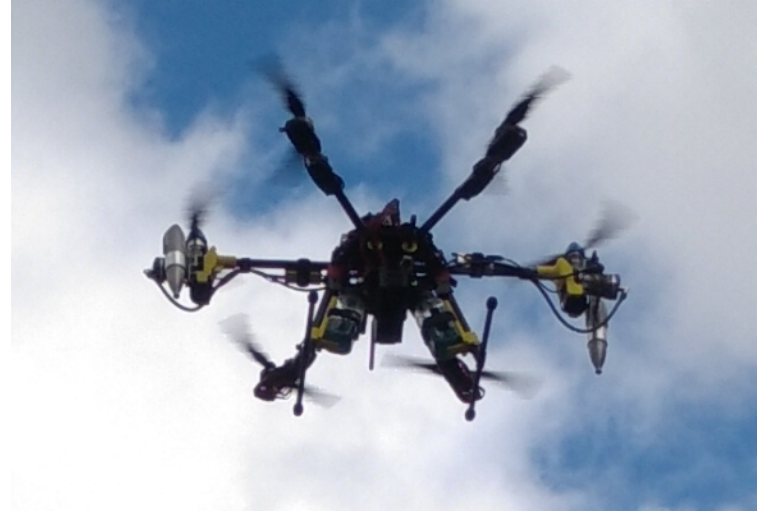
Figure 23. Experimental